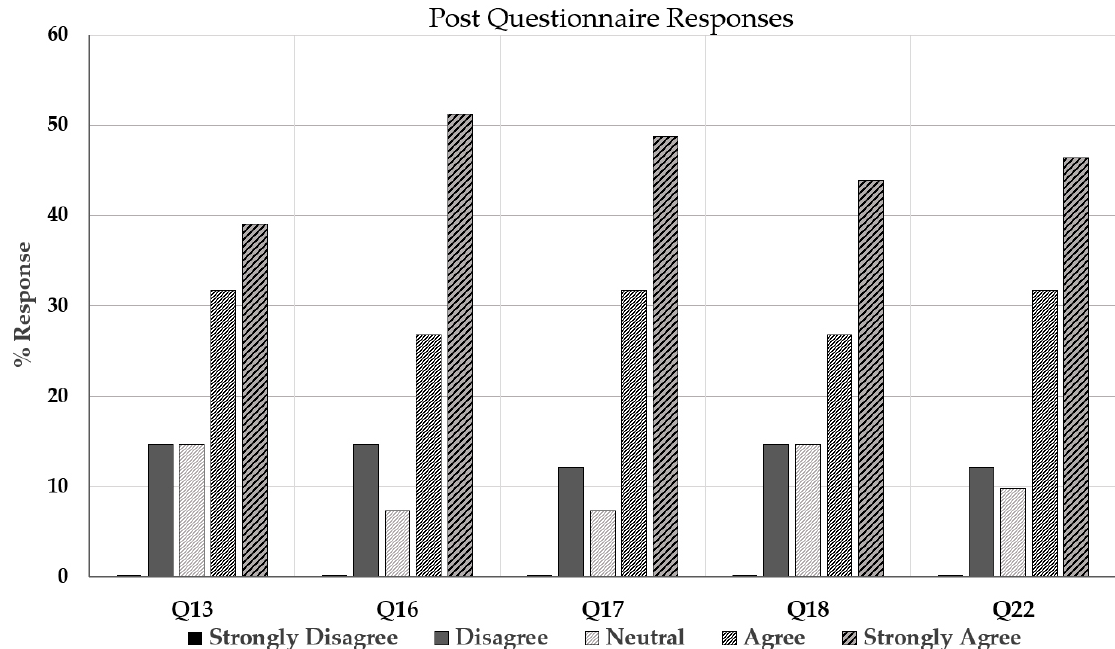
Figure 6. Student responses to question Q13: Using virtual reality saves the time required to learn the chemical structures in medicinal chemistry; Q16: Using the application of 3D models would be easier for me than traditional methods for learning chemical structures in medicinal chemistry; Q17: Using virtual models is useful for me because it will increase my knowledge as I can see the 3D structure model of a drug from several viewing positions; Q18: The experiment content helps me better understand and memorize the chemical structure of a drug; Q22: I would consider using virtual reality visual aids to aid my personal studies outside the classroom.